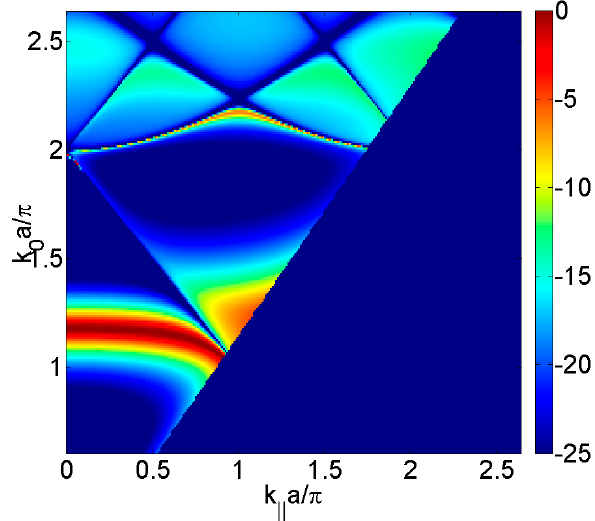
Figure 3. Calculated transmitted sound power coefficient, τ , as a function of the parallel wavevector k ‖ · a / π in the Γ X direction and the normalized frequency k 0 · a / π , for the square distribution of circular holes having diameter, d , of 1 mm and a unit cell period, a , of 3 mm. The transmitted sound is represented in dB scale.